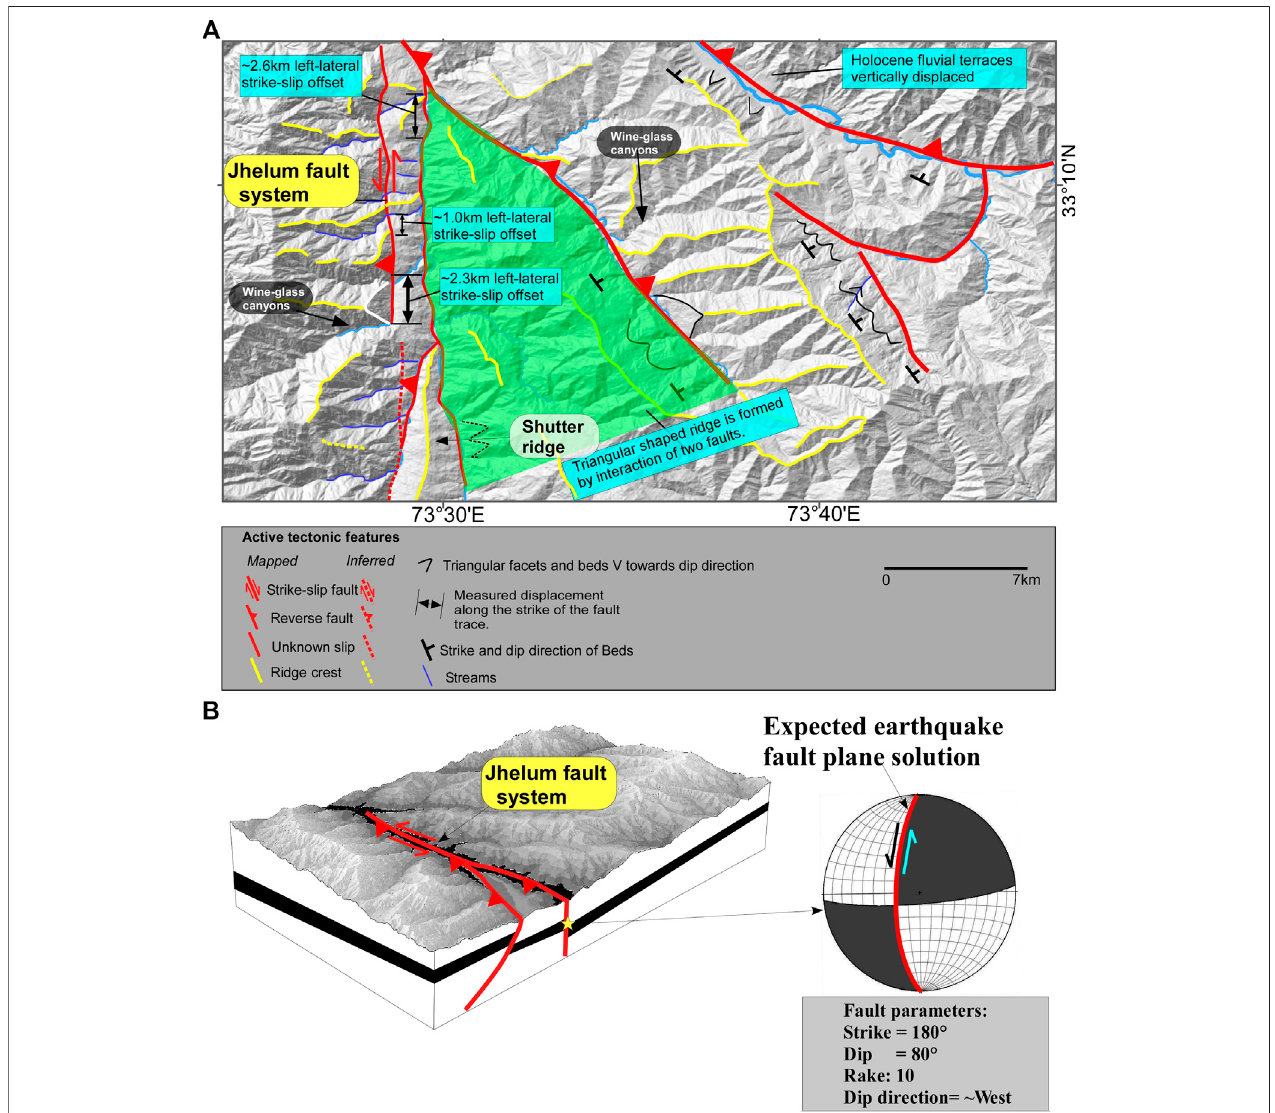
Frontiers in Earth Science |